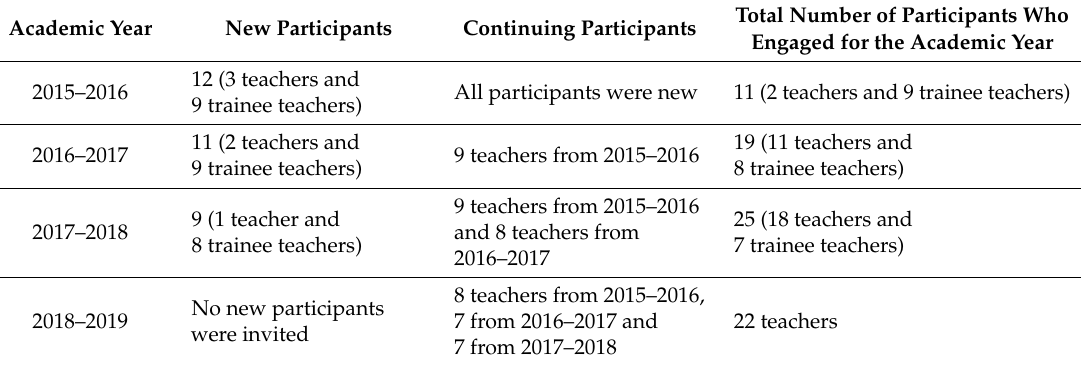
Table 1. Summary of Study Participants from the Period